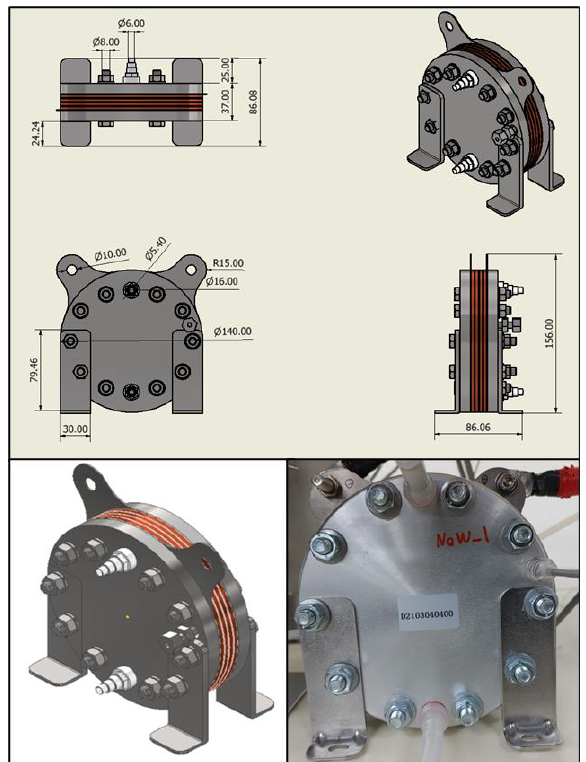
Table 1. Specifications of the PEM electrolyzer.